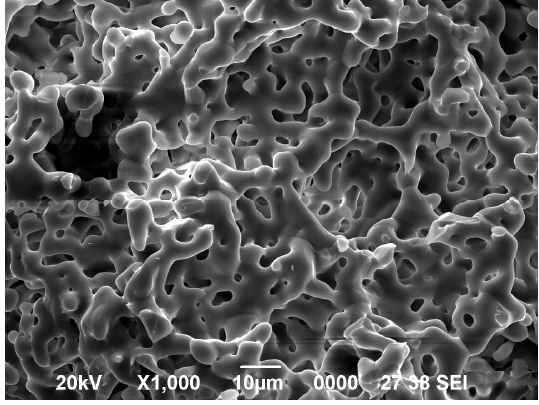
Figure 1. Scanning electron micrographs of alpha-tricalcium phosphate ( α -TCP) particles.